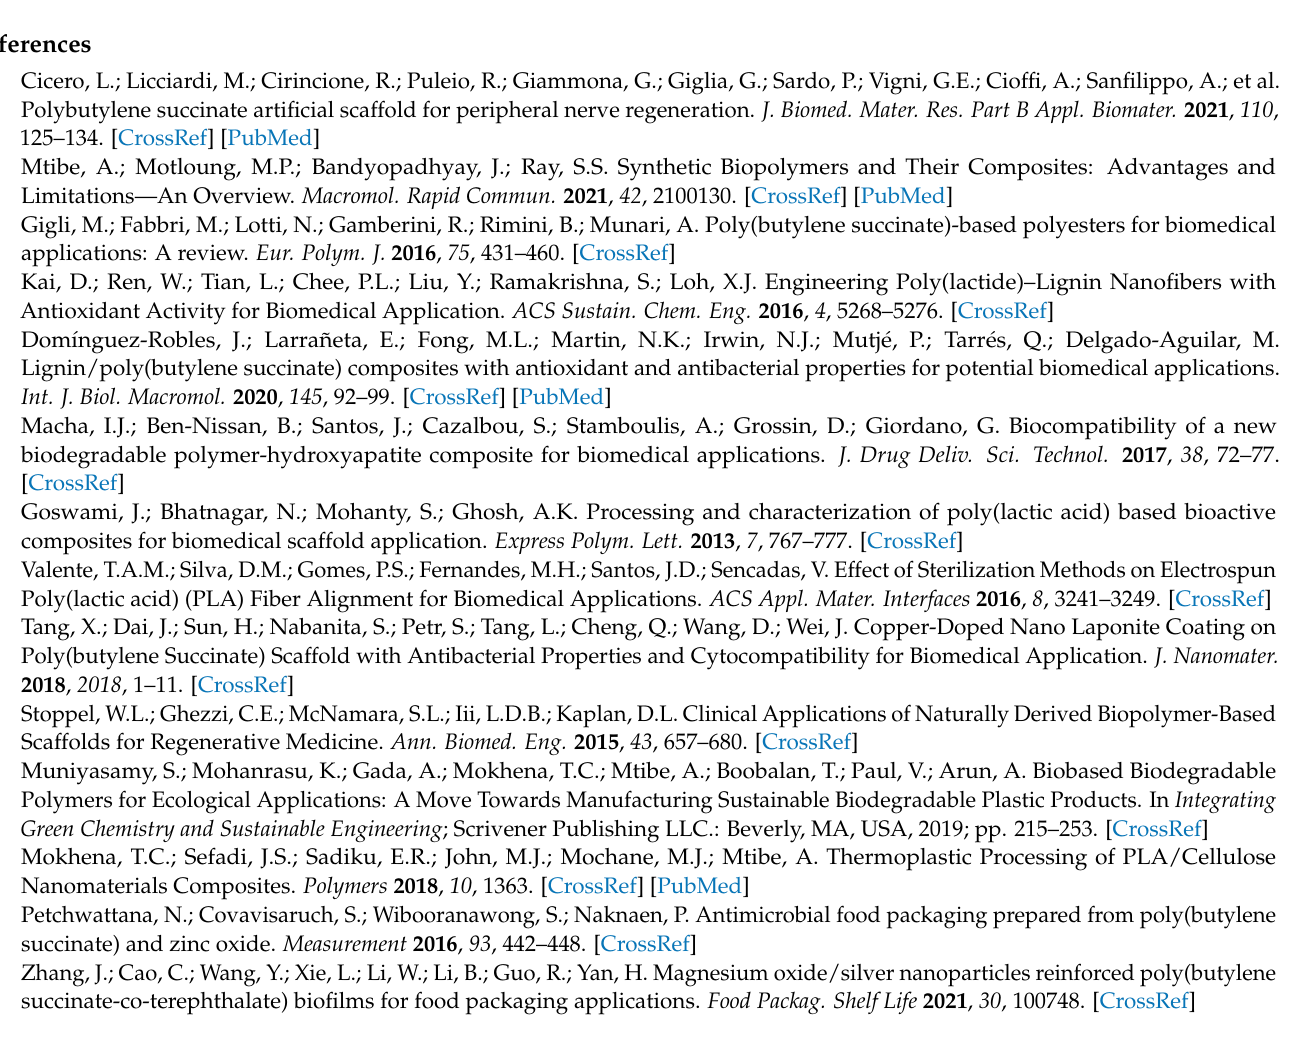
Table S1: Tensile properties of neat biopolymers and their